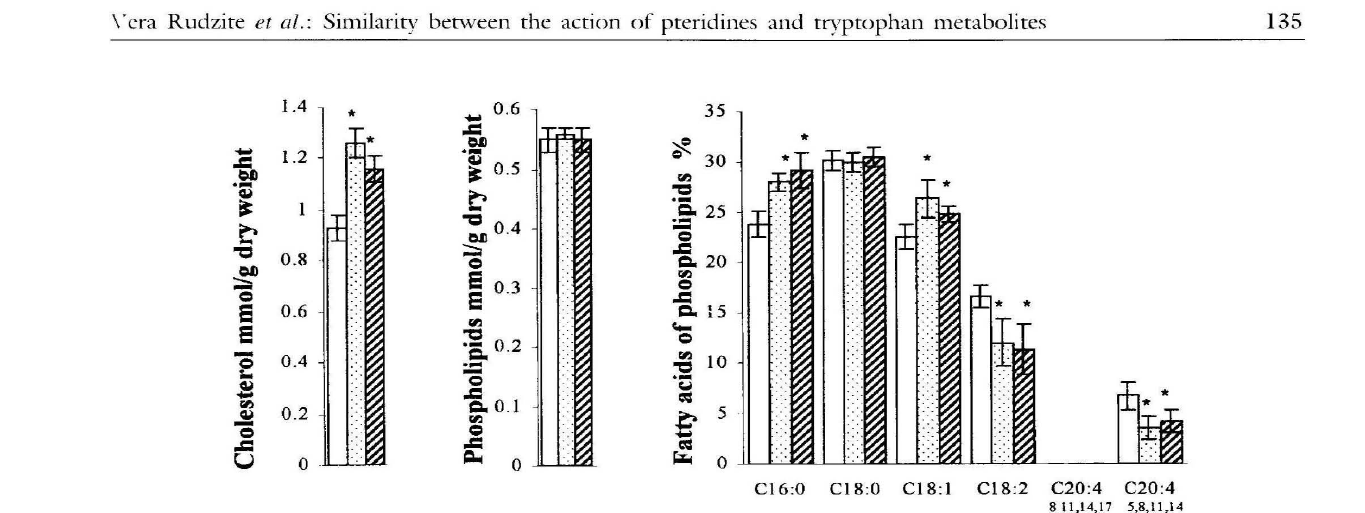
figure 2. Concentrations (mean±S.D.) of cholesterol and phospholipids as well as fatty acid content of phospholipids in percent; mean+S.D.) in controls (open bars) and in samples with 4 nmoljg wet weight kynurenic acid (dotted bars) .1I1d in samples with 40 nmoljg wet weight kynurenic acid (hatched bars). Samples of rat liver tissue homogenates were dsed to test for phospholipid biosynthesis ill vitro. Incubation medium: Krebs - Ringer - phosphate buffer containing 0.3% albumin (pH=7.4), fatty acid mixture and glycerol. Samples were incubated twice for 4 h at 37"C. -The changes are statistically significant (p<0.05 -1'<0.001).